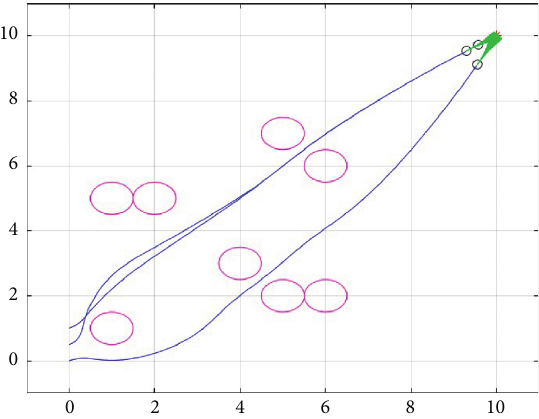
Figure 12: The initial states of the robots.